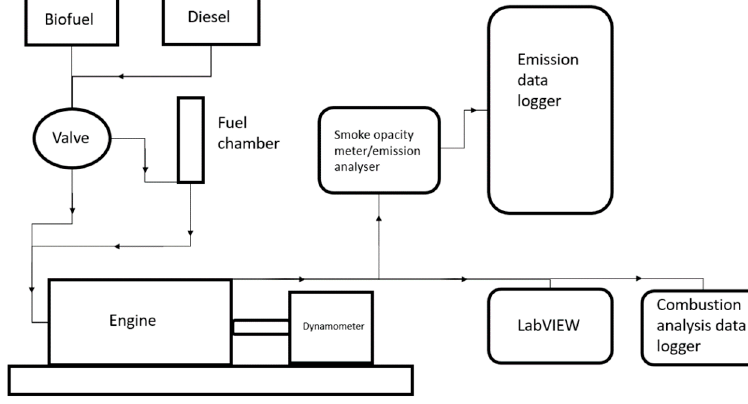
Figure 2. Schematic diagram of the engine test rig.